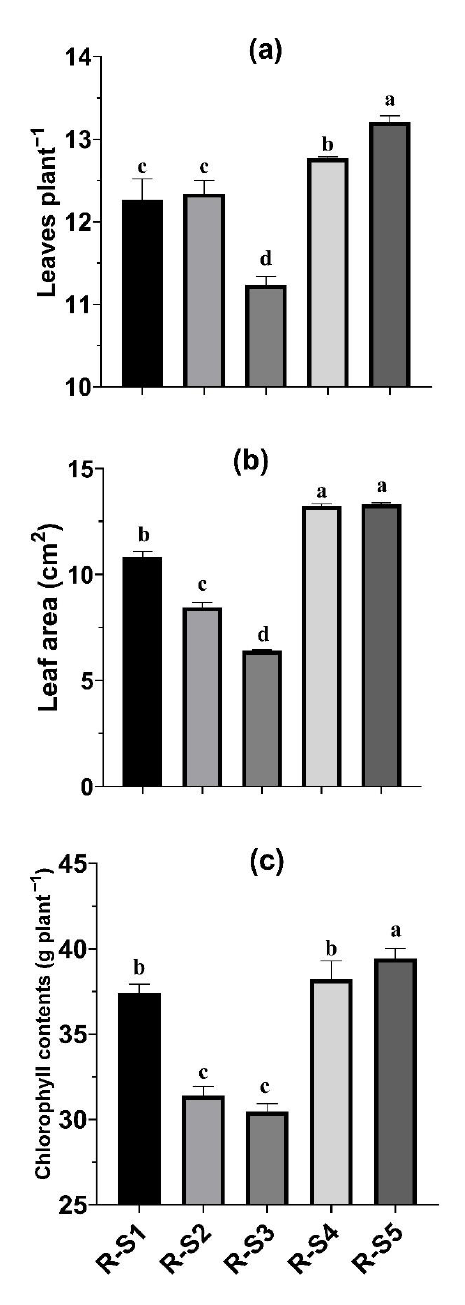
Figure 4. Physiological parameters, i.e., number of leaves plant − 1 ( a ), leaf area ( b ), and